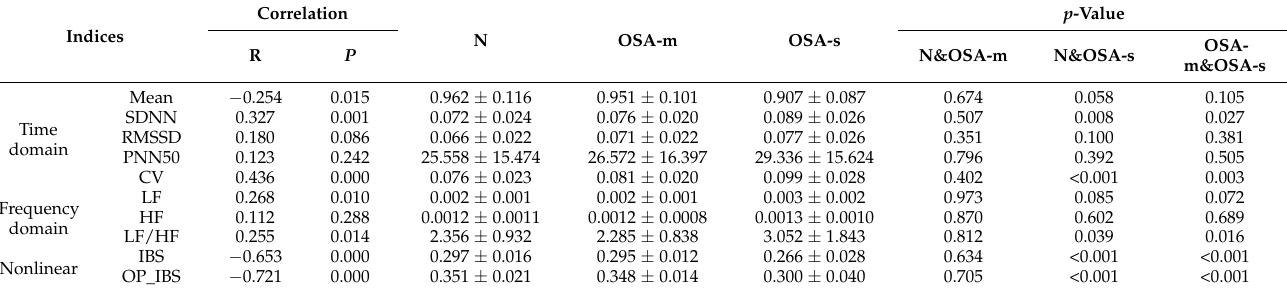
Table 2. Indices for N, M and S groups.